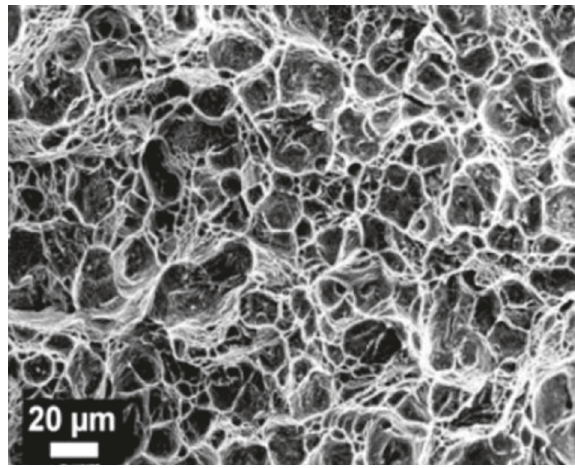
Figure 4: SEM micrograph showing ductile fracture surface dimples